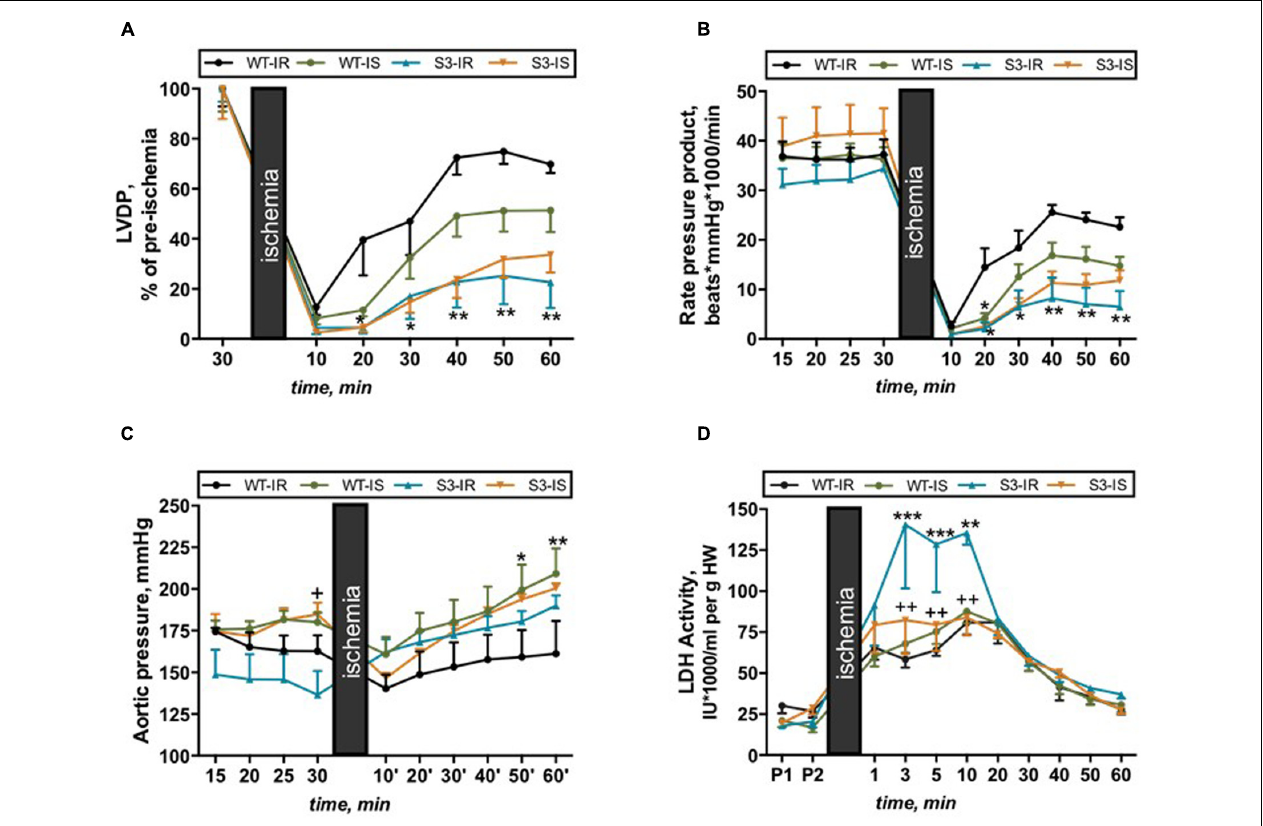
FIGURE 1 | Cardiac function (A – C) and LDH release (D) in Langendorff-perfused hearts isolated from WT and SIRT3 − / − mice and subjected to IR in the presence or absence of SfA. (A) Left ventricle developed pressure (LVDP) expressed as percent recovery of its pre-ischemic values, (B) Cardiac work represented by the RPP, (C) Coronary pressure values shown in mmHg, and (D) LDH activity normalized to heart weight (HW). Groups: WT-IR, WT subjected to IR; WT-IS, WT subjected to IR in the presence of 0.2 µ M SfA; S3-IR, SIRT3 − / − subjected to IR; S3-IS, SIRT3 − / − subjected to IR in the presence of 0.2 µ M SfA. ∗ P < 0.05, ∗∗ P < 0.01, ∗∗∗ P < 0.001 vs. WT-IR; + P < 0.05, ++ P < 0.01 vs. S3-IR. n =